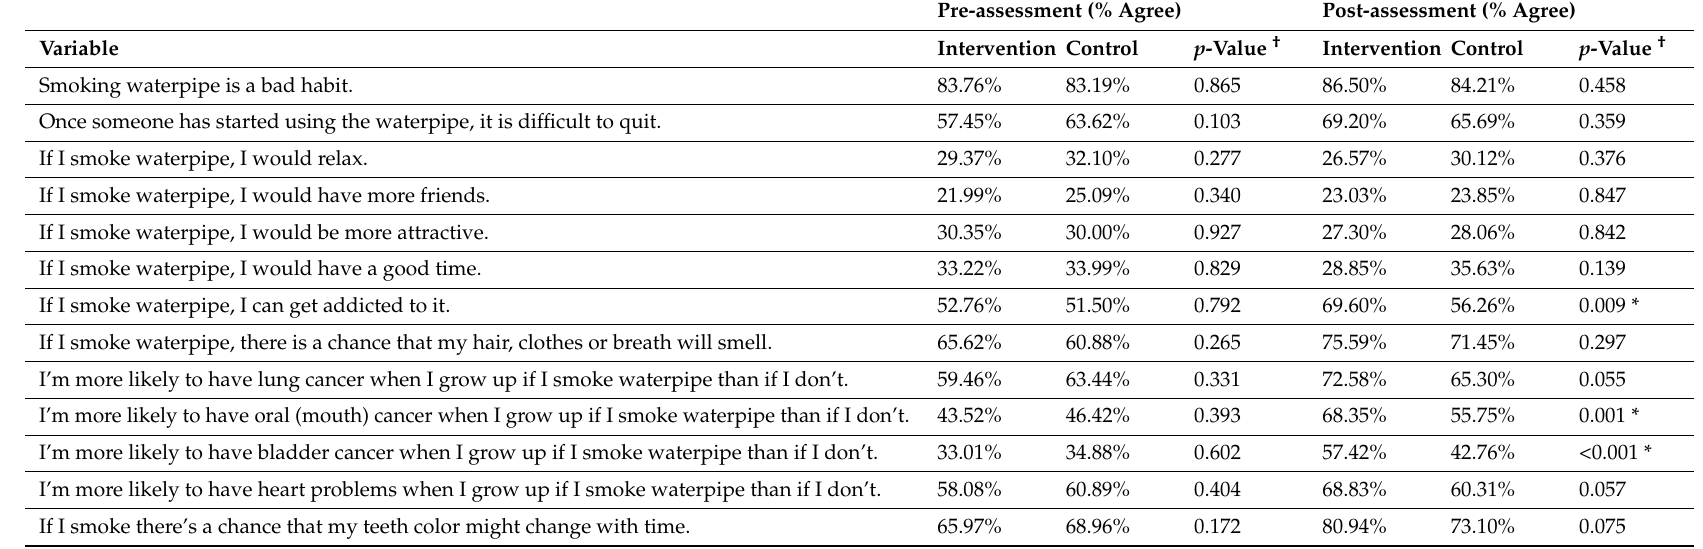
Table 3. Differences in WTS attitudes between intervention and control group participants at pre-assessment and post-assessment. Pre-assessment (% Agree) Post-assessment (% Agree) Variable Intervention Control p -Value † Intervention